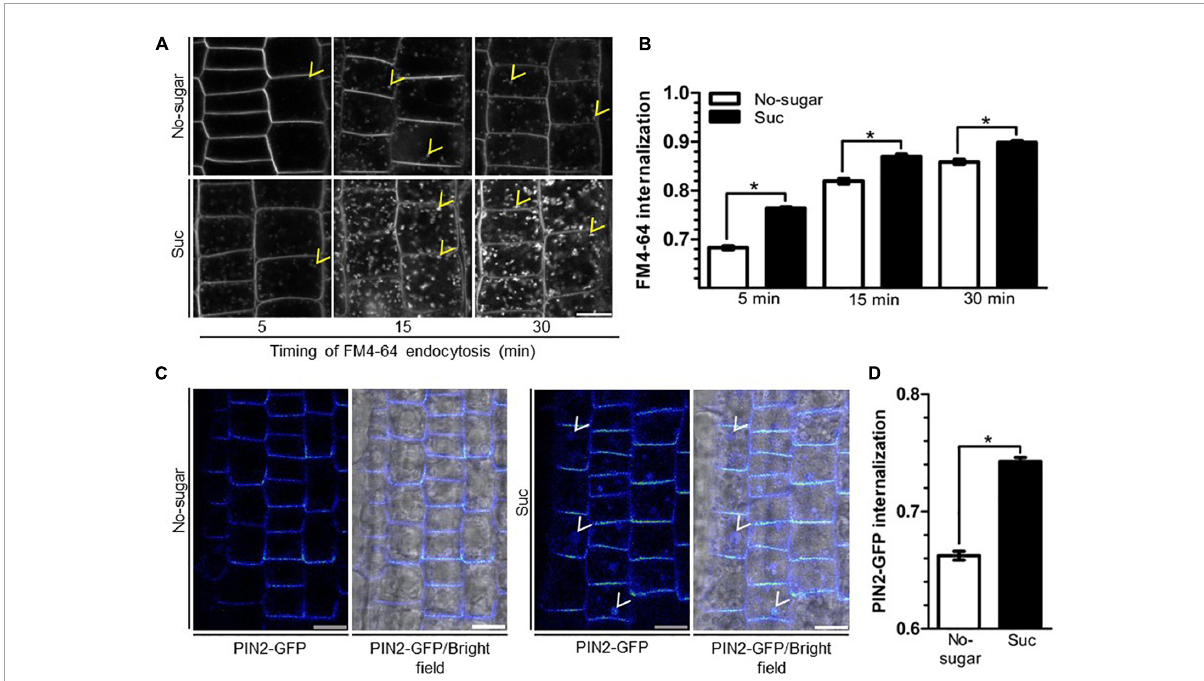
FIGURE2 Sucrose induces plasma membrane endocytosis in root epidermal cells. Arabidopsis wild-type (Col-0) (A,B) or PIN2-GFP (C,D) seedlings were sown on sugar-free (No-sugar) or 60 mM sucrose-supplemented (Suc) solid medium and grown for 7 days. (A) Endocytosis kinetics of FM4-64 were evaluated by confocal imaging of epidermal cells after 5, 15, or 30 min of FM4-64 plasma membrane labeling. About 15 seedlings were evaluated for either condition in experimental triplicates. Representative images are shown. Yellow arrowheads indicate representative FM4-64-stained endosomes. Bar, 10 µ m. (B) FM4-64 uptake was quantified by measuring intracellular and whole-cell FM4-64 signal in each imaged cell. Results are expressed as the ratio between both values. (C) Seedlings were incubated in 50 µ M cycloheximide to exclusively visualize PIN2-GFP endocytic trafficking. After 30 min, seedlings were incubated in the dark for 6 h to induce PIN2 endocytosis toward the vacuole. PIN2-GFP cell distribution was evaluated by confocal microscopy. Representative confocal images from n = 15 seedlings in each condition performed in experimental triplicates are shown as images of Rainbow RGB LUT (Fiji). White arrowheads indicate PIN2-GFP-labeled vacuoles. Bar, 10 µ m. (D) PIN2-GFP internalization was calculated as the intracellular signal relative to the whole-cell signal of seedlings in (C) . (B,D) Standard error for three independent biological replicates is shown. Two-tailed Student’s t -test; * p <